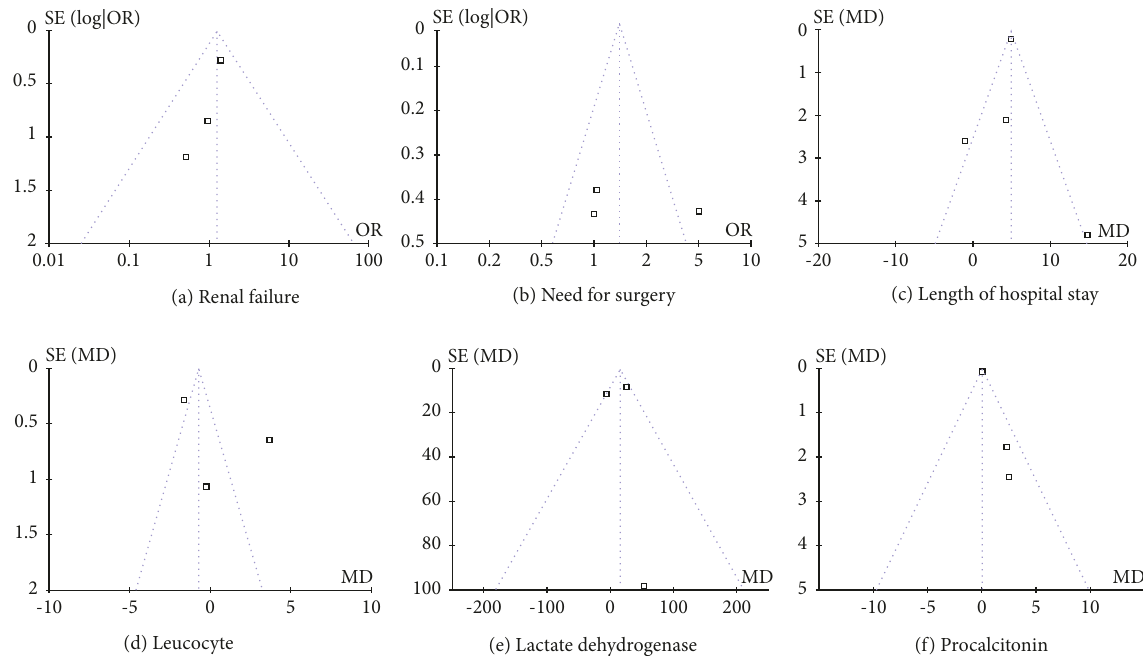
Figure 1: Funnel plot for pooled results. Regarding the funnel plots on pancreatic necrosis, ARDS/ALI, mechanical ventilation, ICU admission, mortality, leucocyte, platelets, and C-reactive protein, all the included studies lay inside the limits of the 95% confidence interval, showing there is no serious publication bias. As for D-dimer, the funnel plot shows included studies lay outside the limits of the 95% confidence interval. ARDS, acute respiratory distress syndrome; ALI, acute lung injury; ICU, intensive care